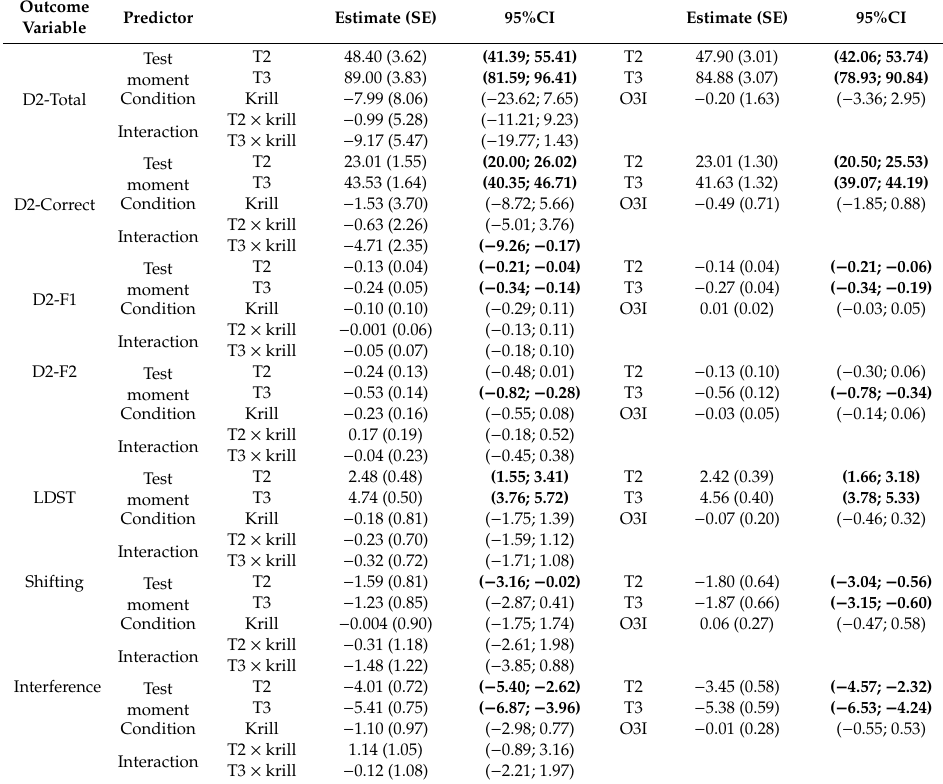
Table 4. Multilevel analyses of cognitive test scores predicted by condition (intention-to-treat) and according to Omega-3 Index.